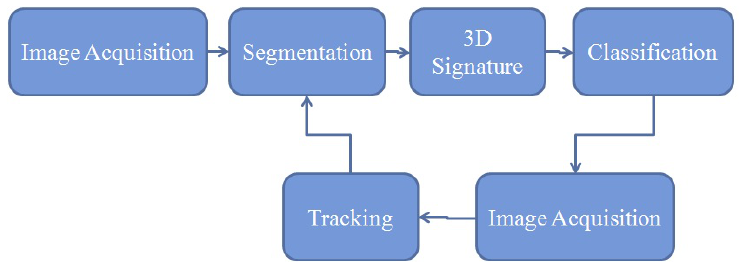
Figure 1. The proposed methodology for hand posture